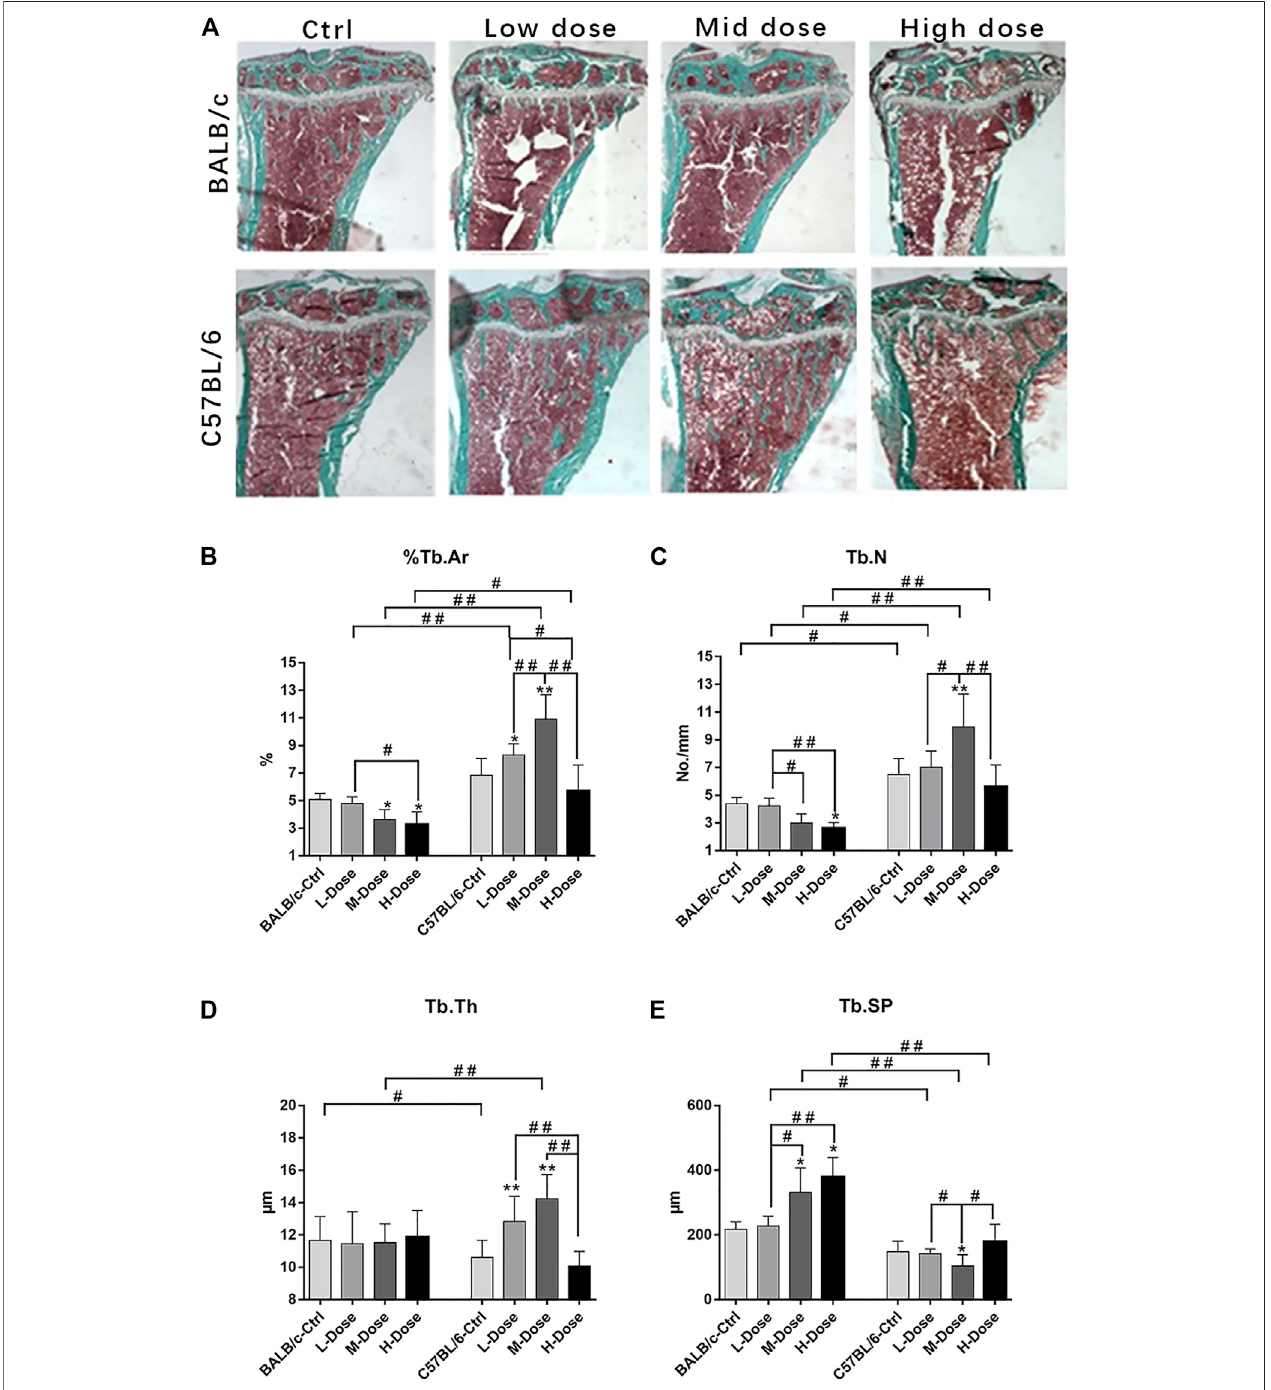
FIGURE 1 | Changes of Trabecular bone of BALB/c and C57BL/6 in dexamethasone treatment. (A) Masson-Goldner Trichrome bone stains of the PTM showing the trabeculae bone loss causing by Dex. (B – E) Static parameters of PTM. * p < 0.05, ** p < 0.01, signi fi cantly different from Ctrl; # p < 0.05, ## p < 0.01, signi fi cantly different between BALB/c and C57BL/6, n (cid:1) 6. (%Tb.Ar, trabecular bone area percentage; Tb.N, trabecular number; Tb.Th, trabecular thickness; Tb. Sp, trabecular separation).